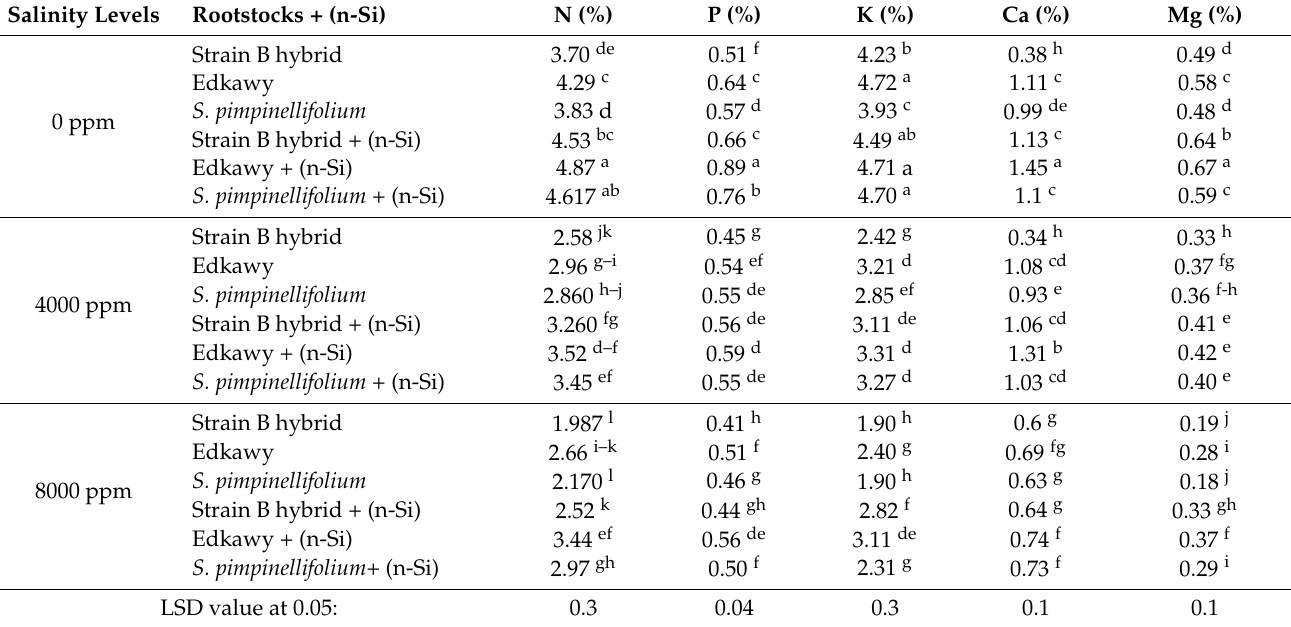
Table 3. Effect of water salinity, grafting, and foliar application of nano-silicon (n-Si) interactions on the mineral contents of tomato shoots (combined 2020 and 2021 seasons).